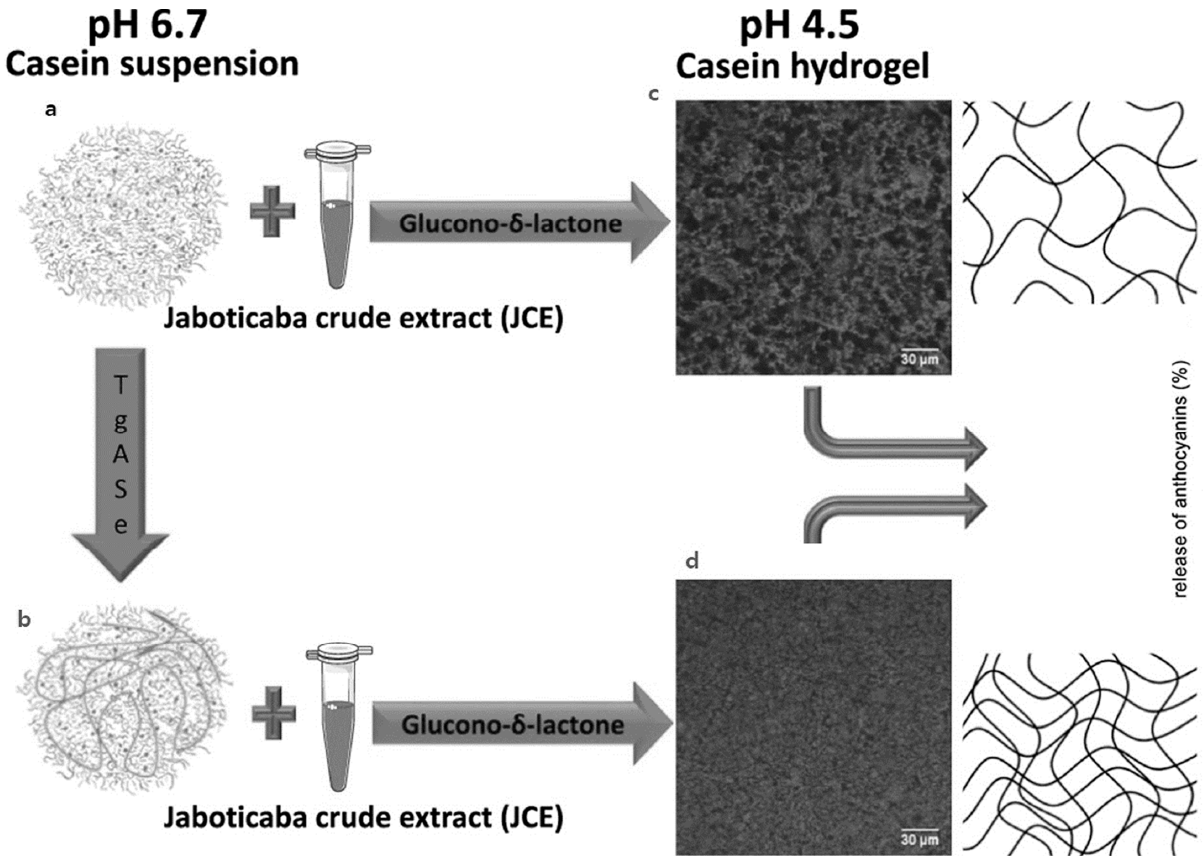
Figure 4. ( a ) Casein micelles; ( b ) Casein micelles plus added transglutaminase; ( c ) Casein hydrogel and added